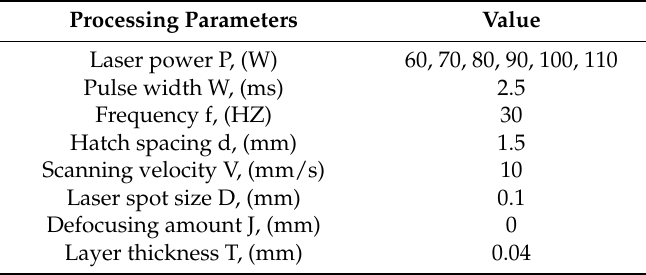
Table 2. LAM parameters used in present